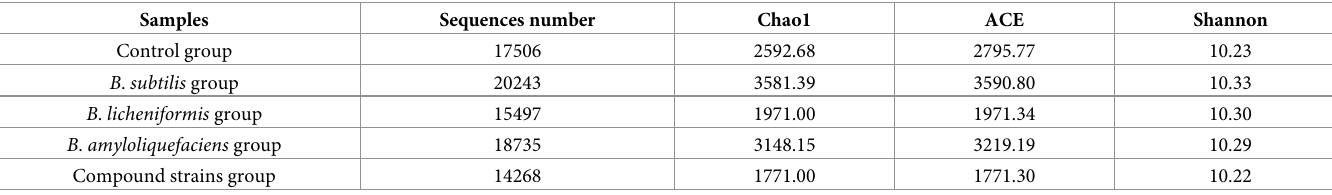
Table 2. Sequencing statistics and diversity indices of the bacterial communities in the different